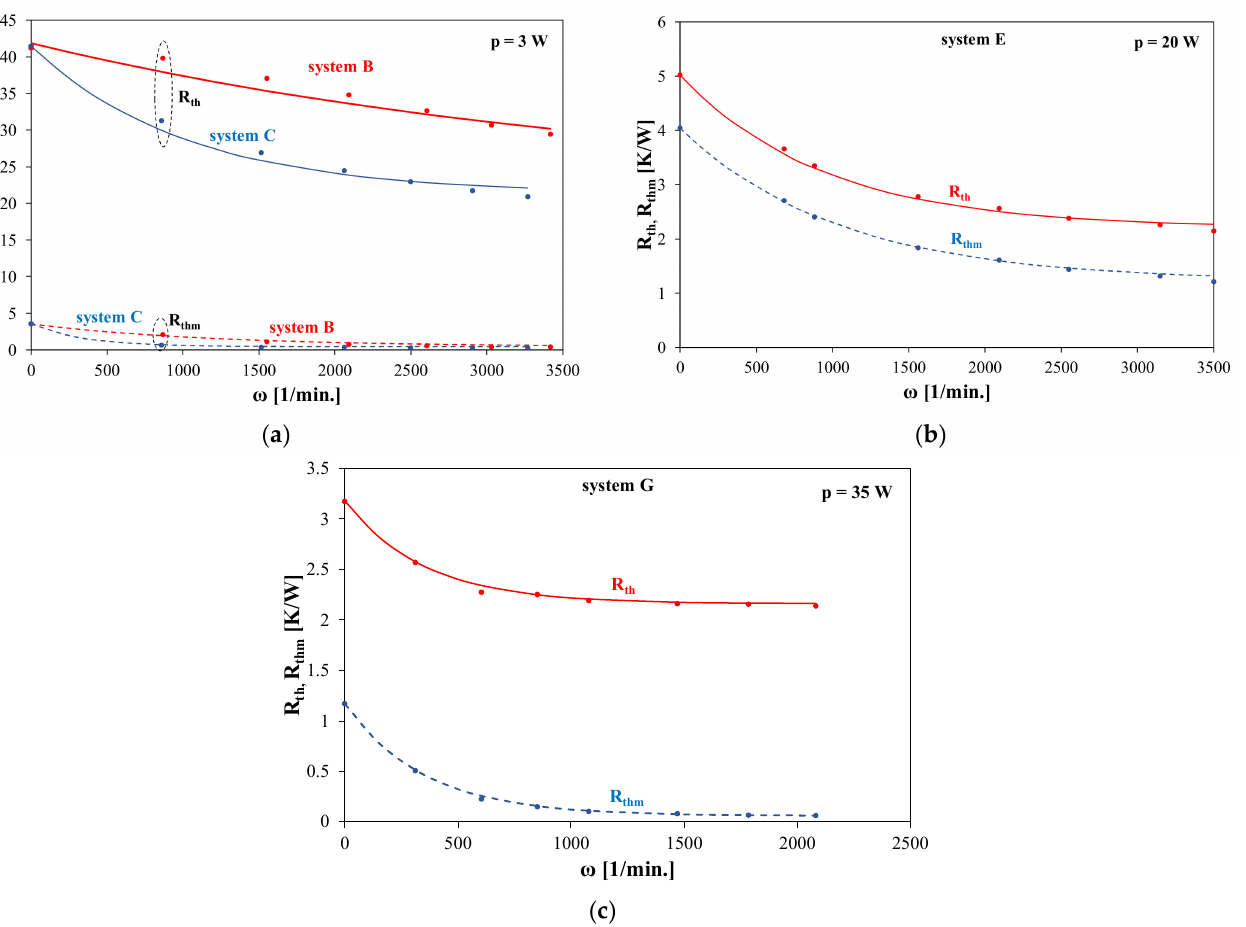
Figure 18. Measured and calculated dependences R th (ω, p) and R thm (ω, p) for the cooling system ( a ) B and C, ( b ) system E and ( c ) system G.